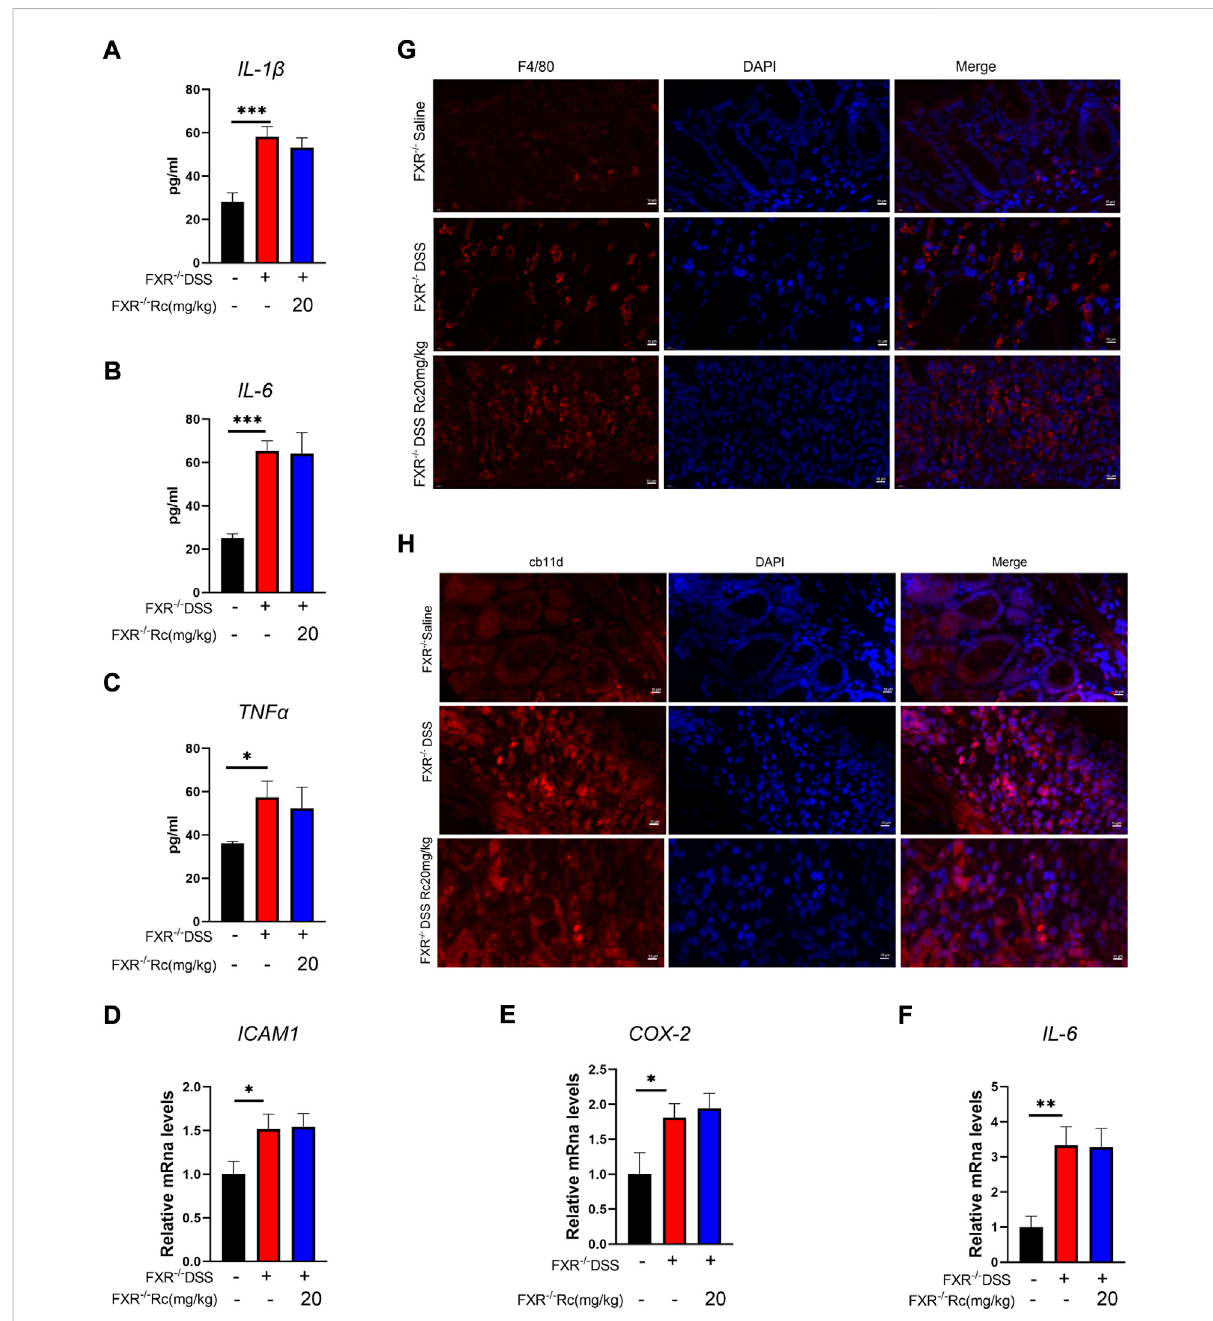
FIGURE 7 The absence of FXR blocked the effect of Rc on suppressing in fl ammation in DSS-induced FXR − / − mice. Serum levels of IL-1 β , IL-6, and TNF- α (A – C) ;thecolons werecollected for qPCRanalysis,andtherelativemRNA levels of ICAM (D) , COX-2 (E) ,and IL-6 (F) weremeasured;representative images of immuno fl uorescence of F4/80 (G) and cd11b (H) in mouse colon sections (magni fi cation: 200 ×). Data are shown as the mean ± SEM ( n = 6). * p < 0.05, ** p < 0.01, *** p < 0.001 vs . the saline